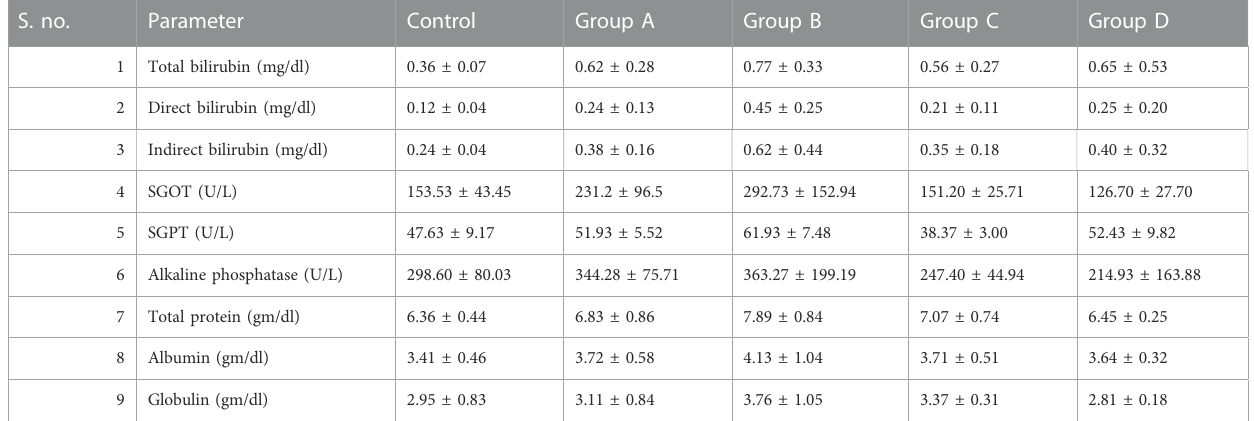
TABLE 3 Liver function parameters in rats after 14 days of oral NVA-IT administration. S. no.